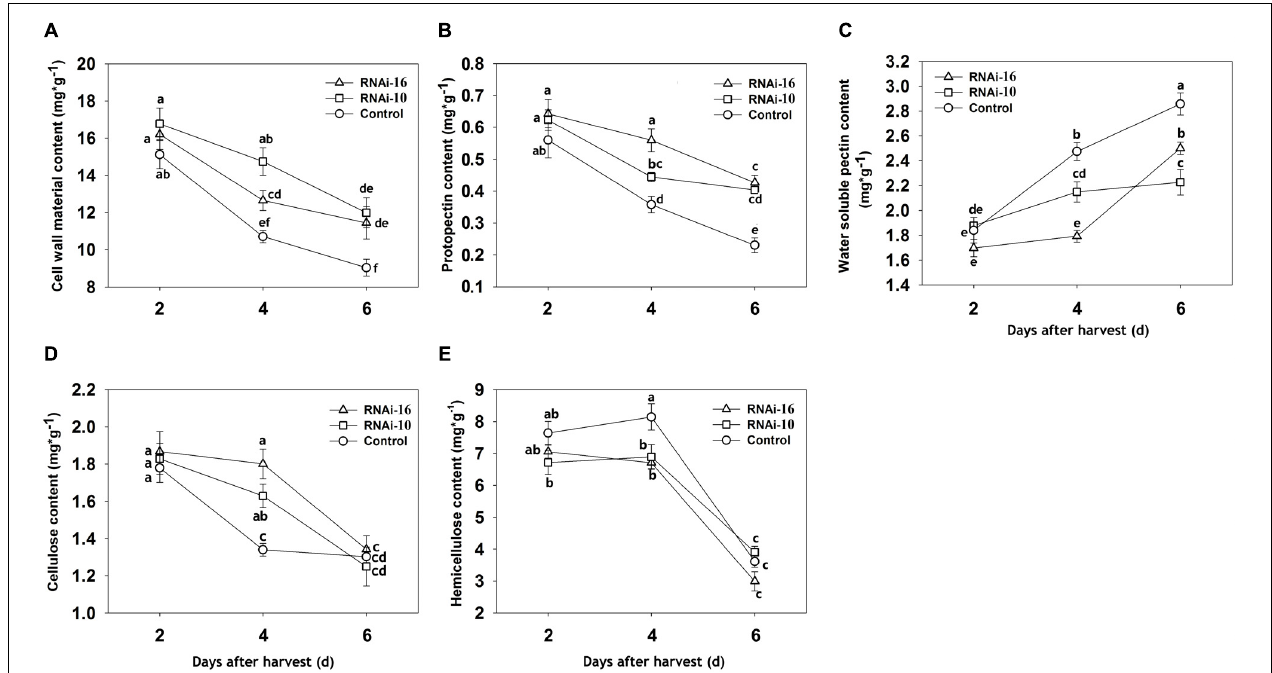
FIGURE 5 | Changes in the level of cell wall components in control (TRV2), RNAi-10 (TRV2- PpBGAL10 ), and RNAi-16 (TRV2- PpBGAL16 ) fruit. (A) Cell wall material (dry mass), (B) protopectin, (C) water-soluble pectin, (D) cellulose, and (E) hemicelluloses in RNAi and control fruit during storage. Each experiment was repeated three times. Bars represent the mean ± SE ( n = 3). Significant differences ( p < 0.05) between means are indicated by different